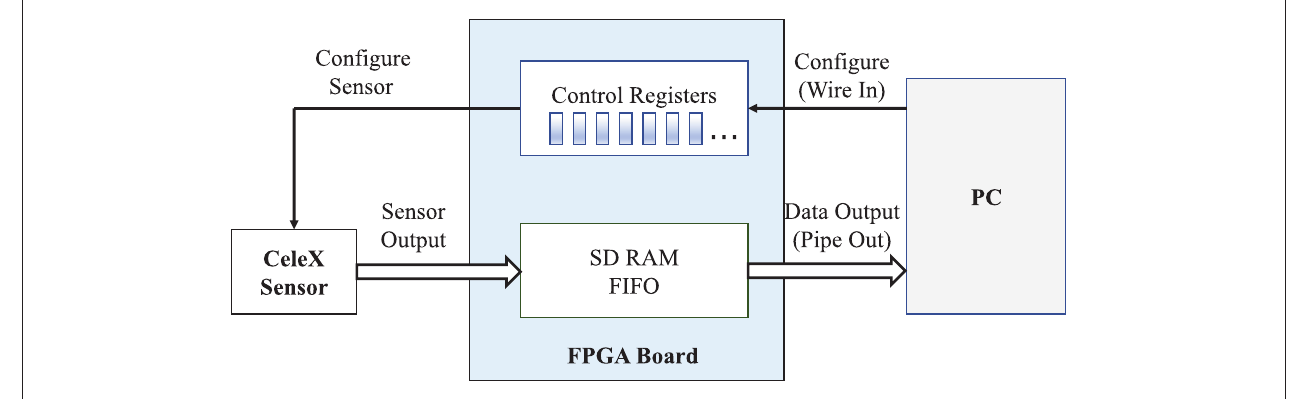
FIGURE 1 | The working principle of the CeleX TM